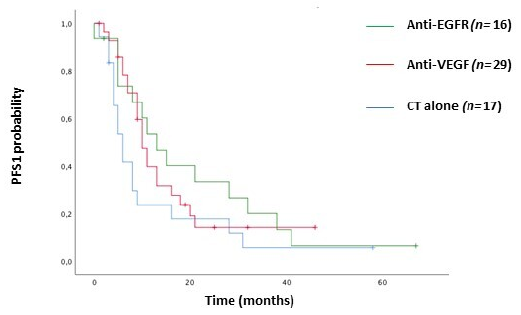
Figure 3. Kaplan–Meier curves for progression-free survival (PFS) according to first-line treatment.